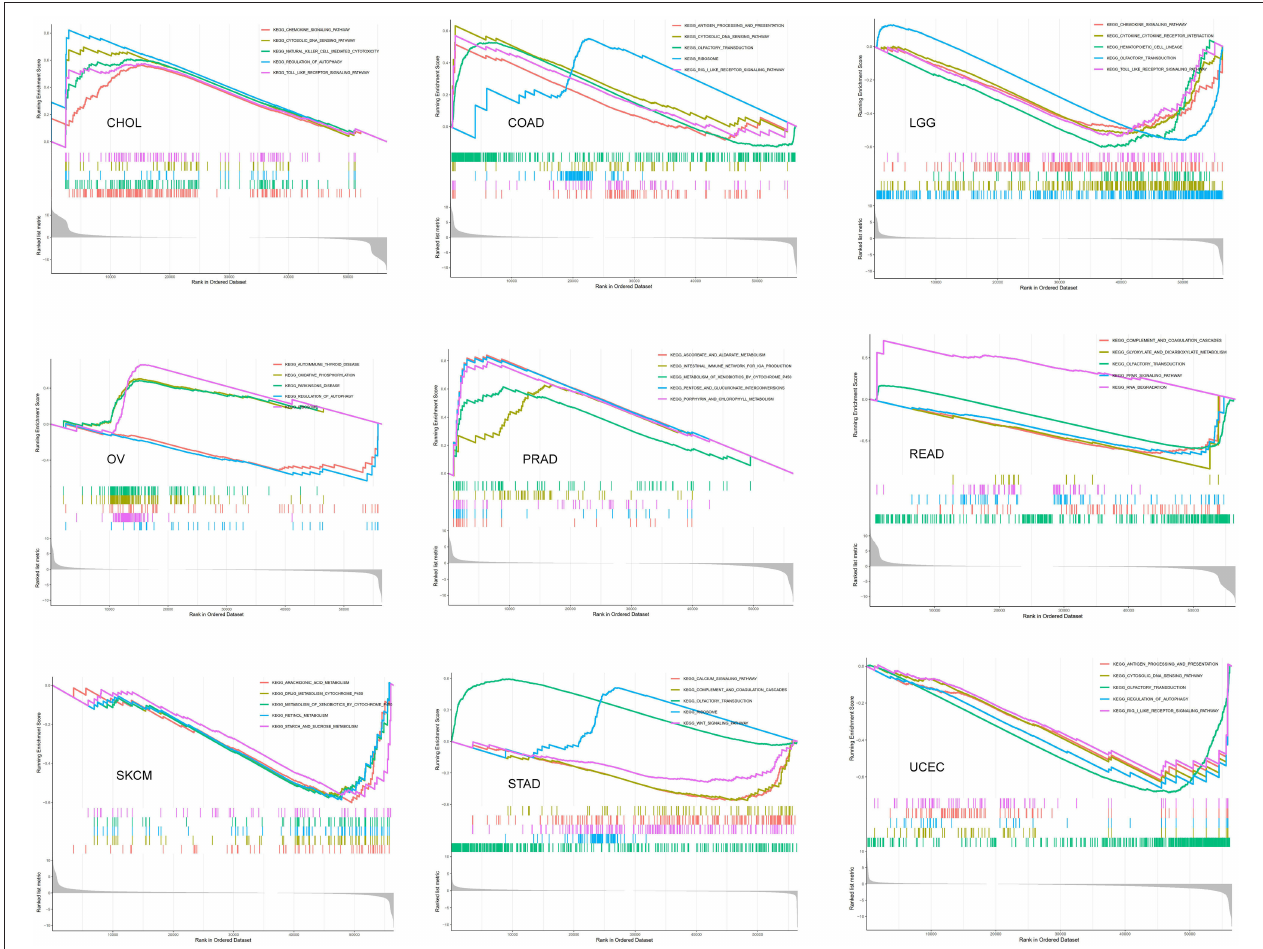
FIGURE 11 | The gene set enrichment analysis (GSEA) analysis in Kyoto Encyclopedia of Genes and Genomes (KEGG) signature of cholangiocarcinoma (CHOL), colon adenocarcinoma (COAD), brain lower-grade glioma (LGG), ovarian serous cystadenocarcinoma (OV), PRAD, rectum adenocarcinoma (READ), skin cutaneous melanoma (SKCM), stomach adenocarcinoma (STAD), and uterine corpus endometrial carcinoma (UCEC). The different colors curves represent the different functions or pathways. The peaks on the upward curve indicate positive regulation by SRI and peaks on the downward curve indicate negative regulation by SRI.